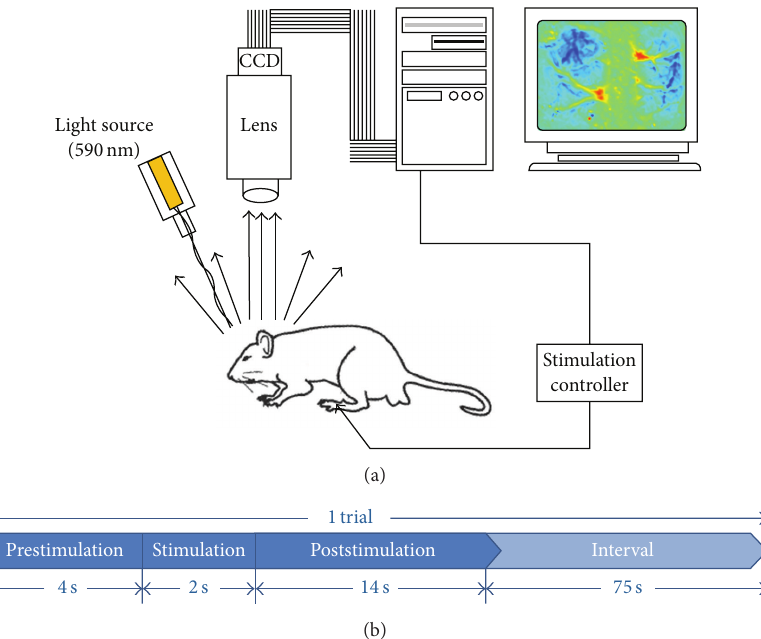
Figure 3: Schematic of optical intrinsic signal (OIS) imaging system and hindlimb electrical stimulation protocol. (a) The head of rat was fixed in a stereotaxic frame and then illuminated by a 590 nm LED throughout the experiment. The ipsilesional hindlimb was stimulated with different intensity of currents (2mA, 3.5 mA, and 5mA). OIS images were captured by a CCD camera connected with a lens and then transferredtothecomputerforfurtherprocessing.(b)EachtrialofOISrecordingsconsistedofa4 srestingstateanda2 selectricalstimulation followed by a 14 s poststimulation state. For each intensity of stimulation, 12 trials of data were recorded at an intertrial interval of 75 s.